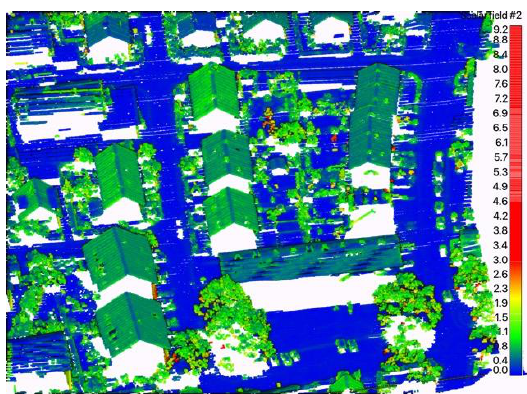
Figure 8. Elevation change feature visualized on a part of Vaihingen’s training data. Unit of the legend is